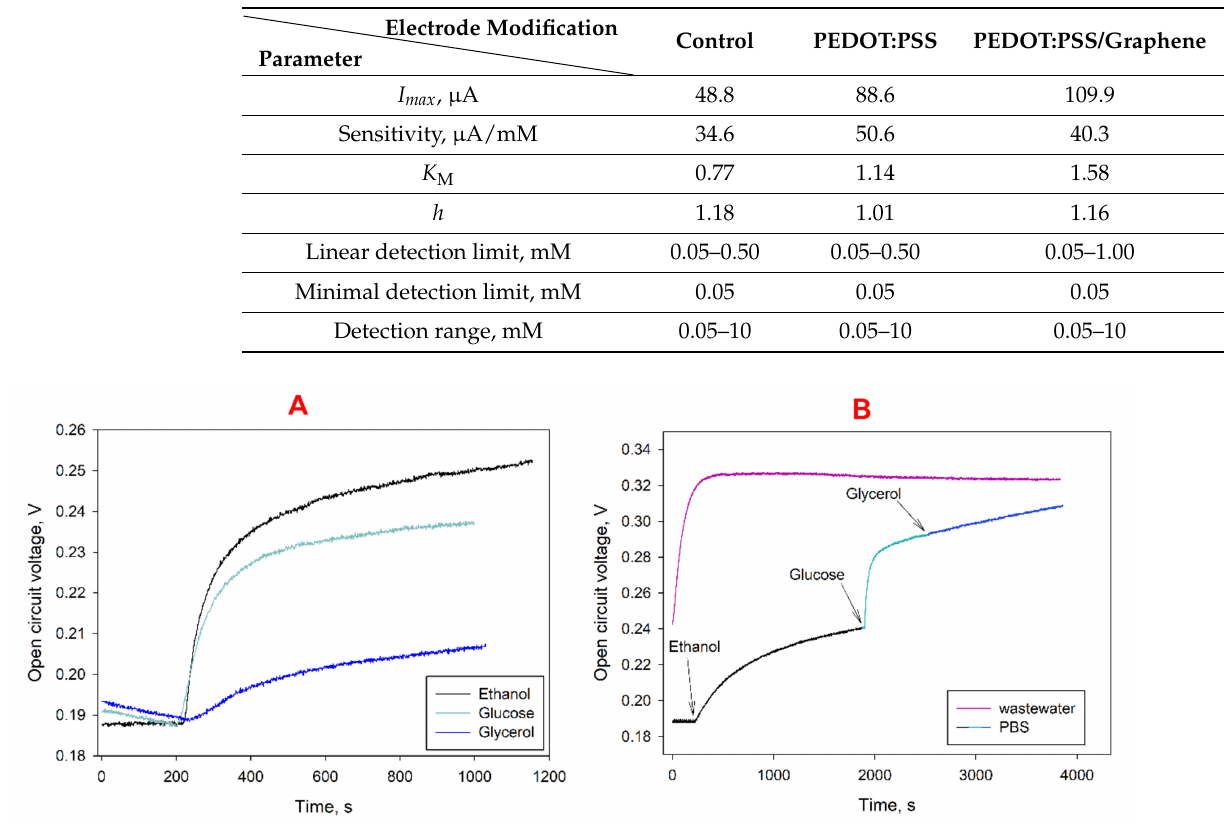
Table 1. Characteristics of the bioanodes of MFCs, used as biosensors for ethanol detection.